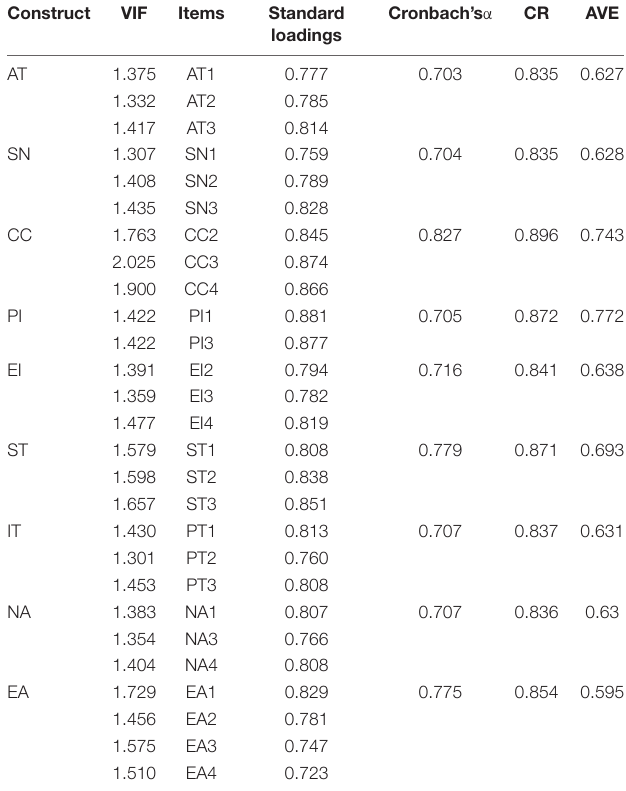
TABLE 2 | Reliability and validity tests of the